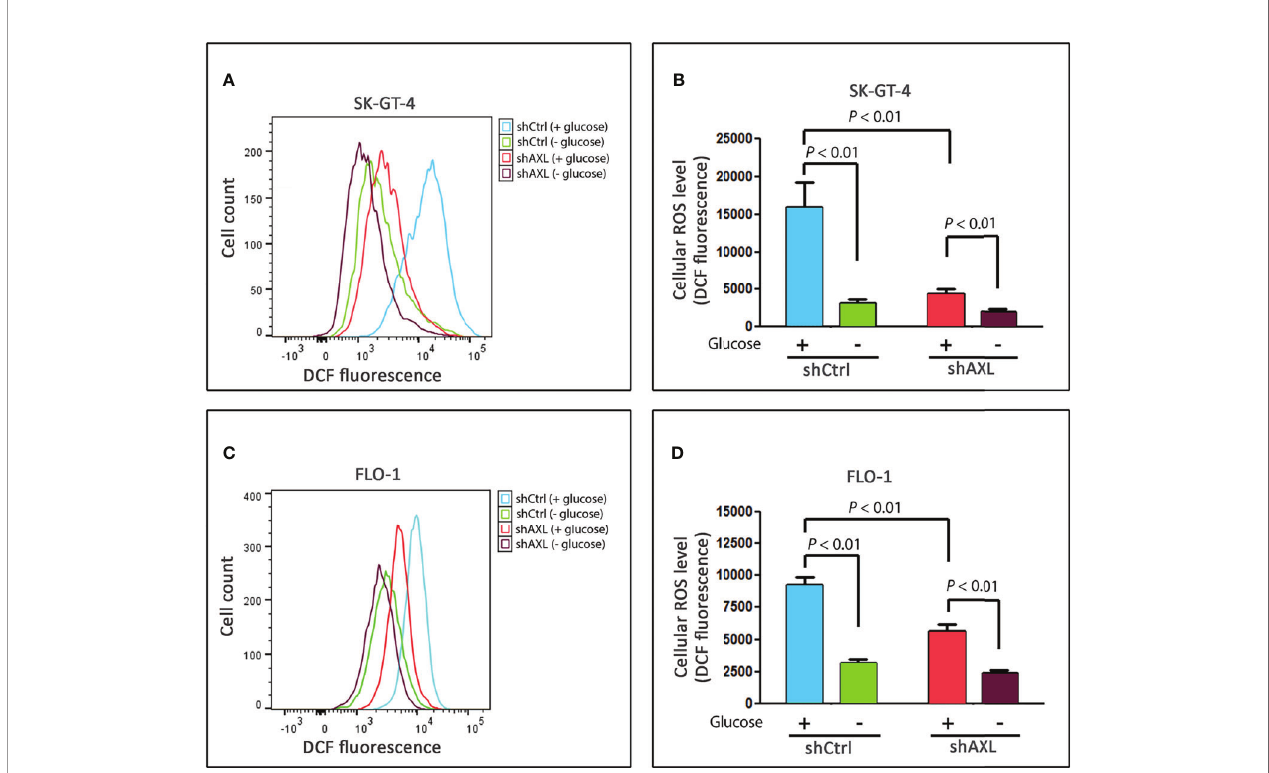
FIGURE 4 | AXL is a positive regulator of basal cellular ROS levels in EAC cells. SK-GT-4-shCtrl and SK-GT-4-shAXL cells (A , B) or FLO-1-shCtrl and FLO-1-shAXL cells (C , D) were cultured in the presence or absence of glucose for 4 h, and then subjected to staining with DCFDA and followed by fl ow cytometry for detection of cellular ROS. Data are representative of three independent experiments and statistical signi fi cance was evaluated by one-way ANOVA followed by the Newman- Keuls post hoc test.